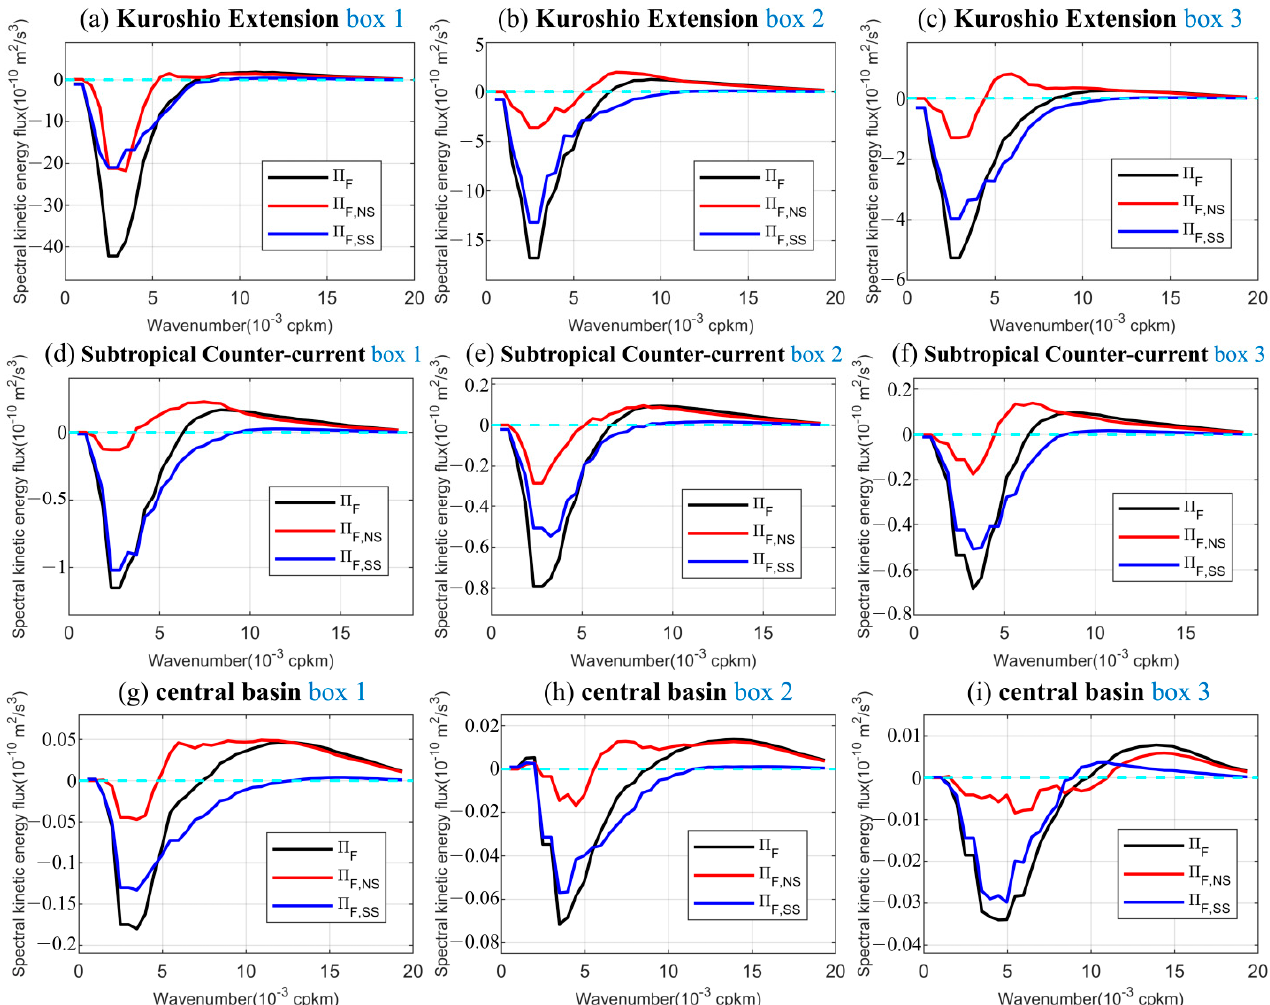
Figure 10. Same as Figure 9 (i.e., at 100 m) except using Π F with preprocessed velocity data.